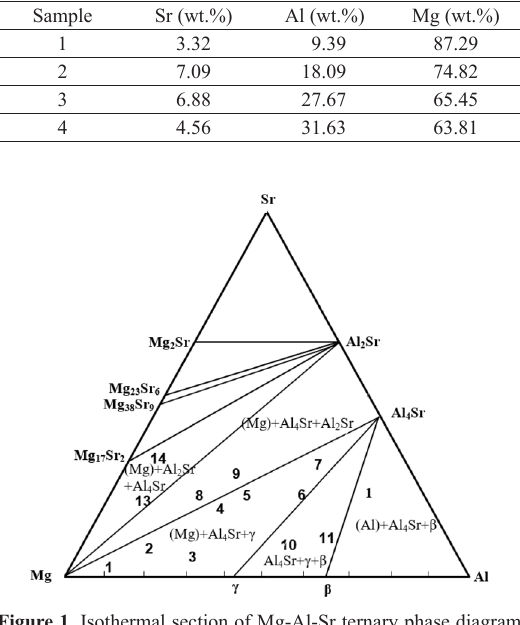
Figure 1. Isothermal section of Mg-Al-Sr ternary phase diagram at 25°C with the studied samples 21 .